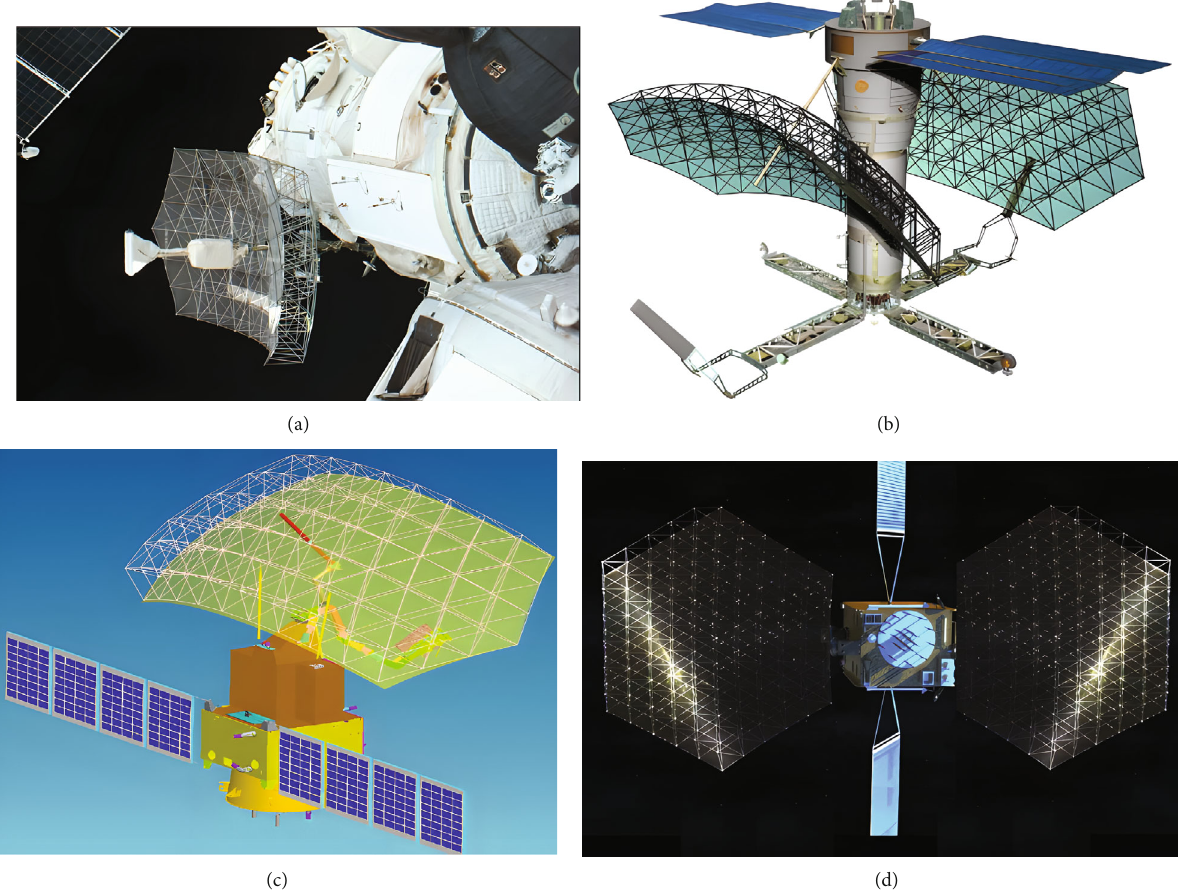
Figure 1: Applications of modular truss antenna. (a) “ Mir ” space station. (b) Pion satellite. (c) Environmental disaster reduction satellite. (d) BeiDou navigation